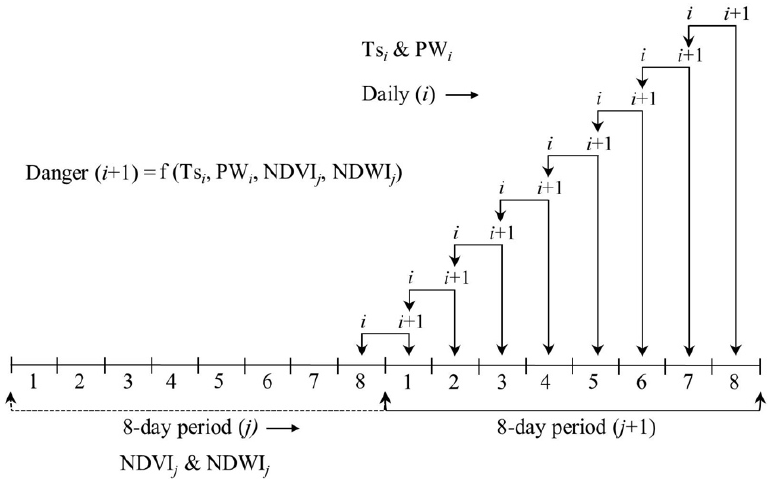
Figure 4. The schematic diagram of employed method, along with characteristics of danger condition in day ( i + 1) using the model input variables including: actual daily surface temperature (Ts i ) and precipitable water (PW i ); and synthetic daily normalized difference vegetation index (NDVI j ) and normalized difference water index (NDWI j